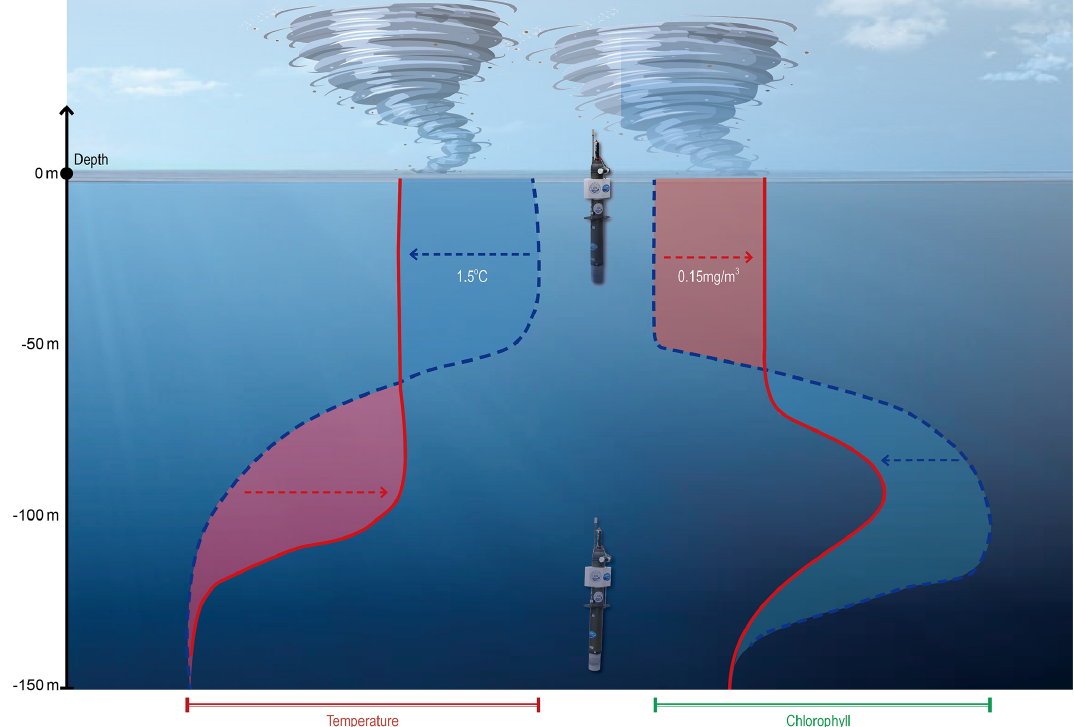
Figure 5. Schematic diagram for a typhoon’s impact on the vertical distribution of temperature (left) and chlorophyll (right). Blue dashed (red solid) lines correspond to vertical profiles before (after) a typhoon; blue and red dashed arrows mean decrement and increment, respectively, of temperature and